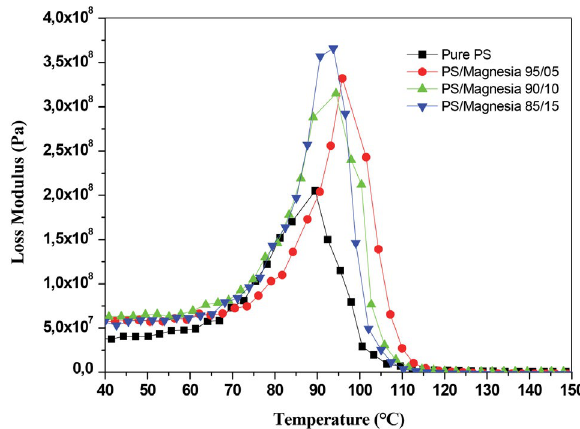
Figure 3: Loss modulus variations of pure PS and PS/Magnesia composites.